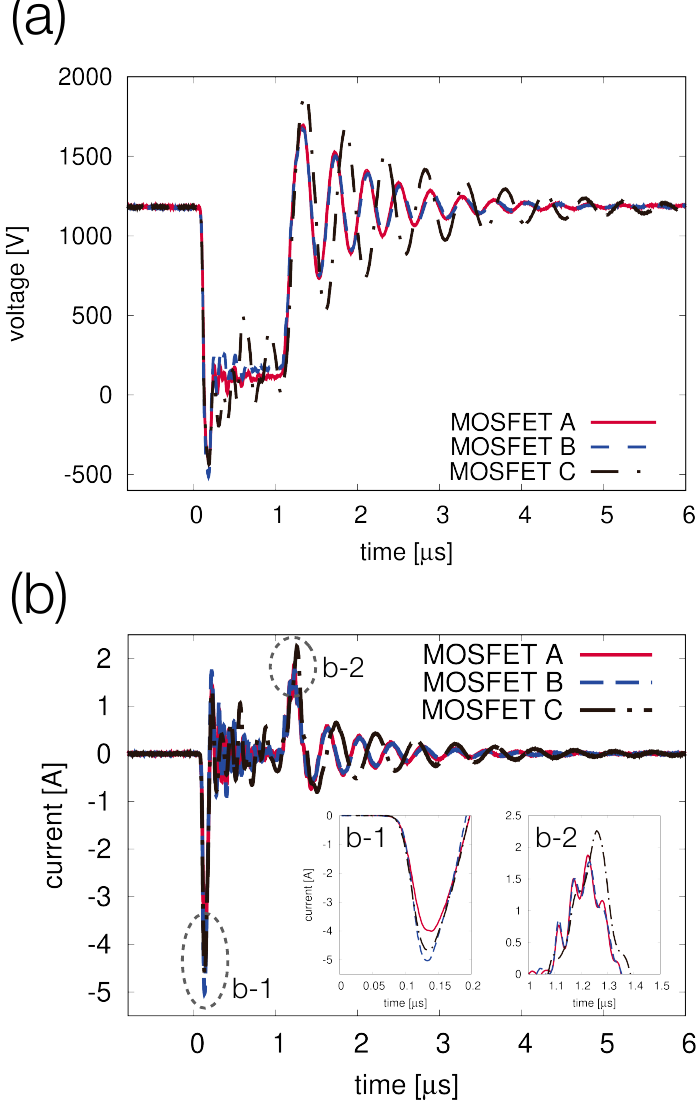
Figure 3. Time histories of ( a ) applied voltage and ( b ) discharge current for different